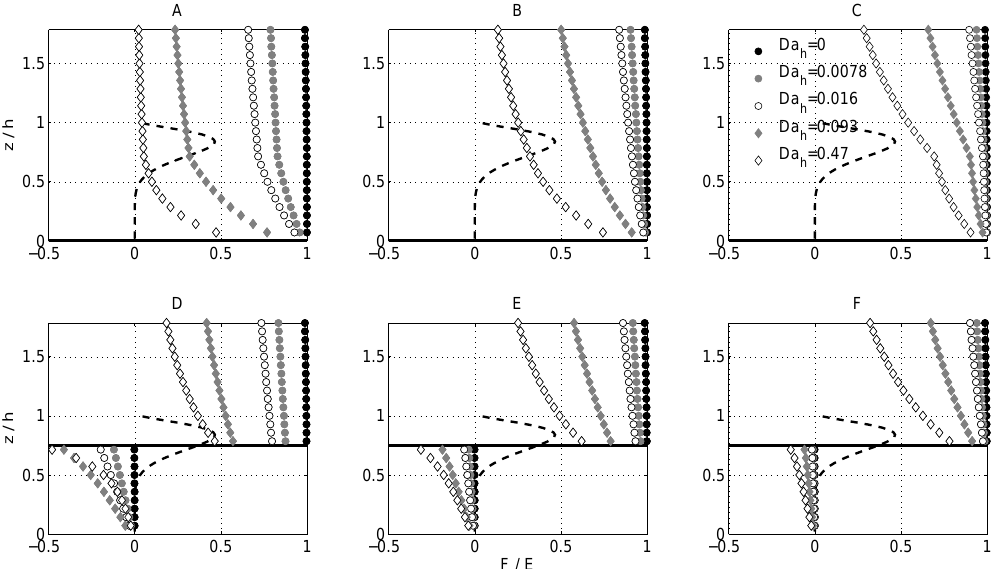
Fig. 2. Flux-to-surface-exchange ( F / E ) ratio profiles. The source height, represented by the solid black line, is at the ground level in Panels (A) – (C) and at the displacement height in Panels (D) – (F) . In Panels (B) and (E) the vertical profile of oxidation rate is constant. In Panels (A) and (D) the oxidation rate below the displacement height is four times faster than above that. In Panels (C) and (F) the oxidation rate below displacement height is one-fourth of that above displacement height. The canopy-top Damk¨ohler refers to the above canopy chemical lifetime in all Panels. The dashed black line represents the foliage